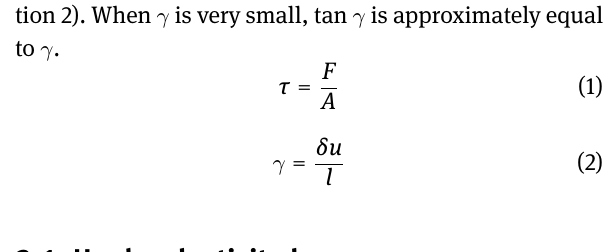
Shear stress ( τ ) is defined as tangential force (F) per unit of area (A) as shown in Figure 1 and Equation 1. Shear strain ( 𝛾 ) is defined as the angle of the displacement re- lated to a reference layer i.e. , the tangential displacement ( δu ) per distance (l) between two parallel plates